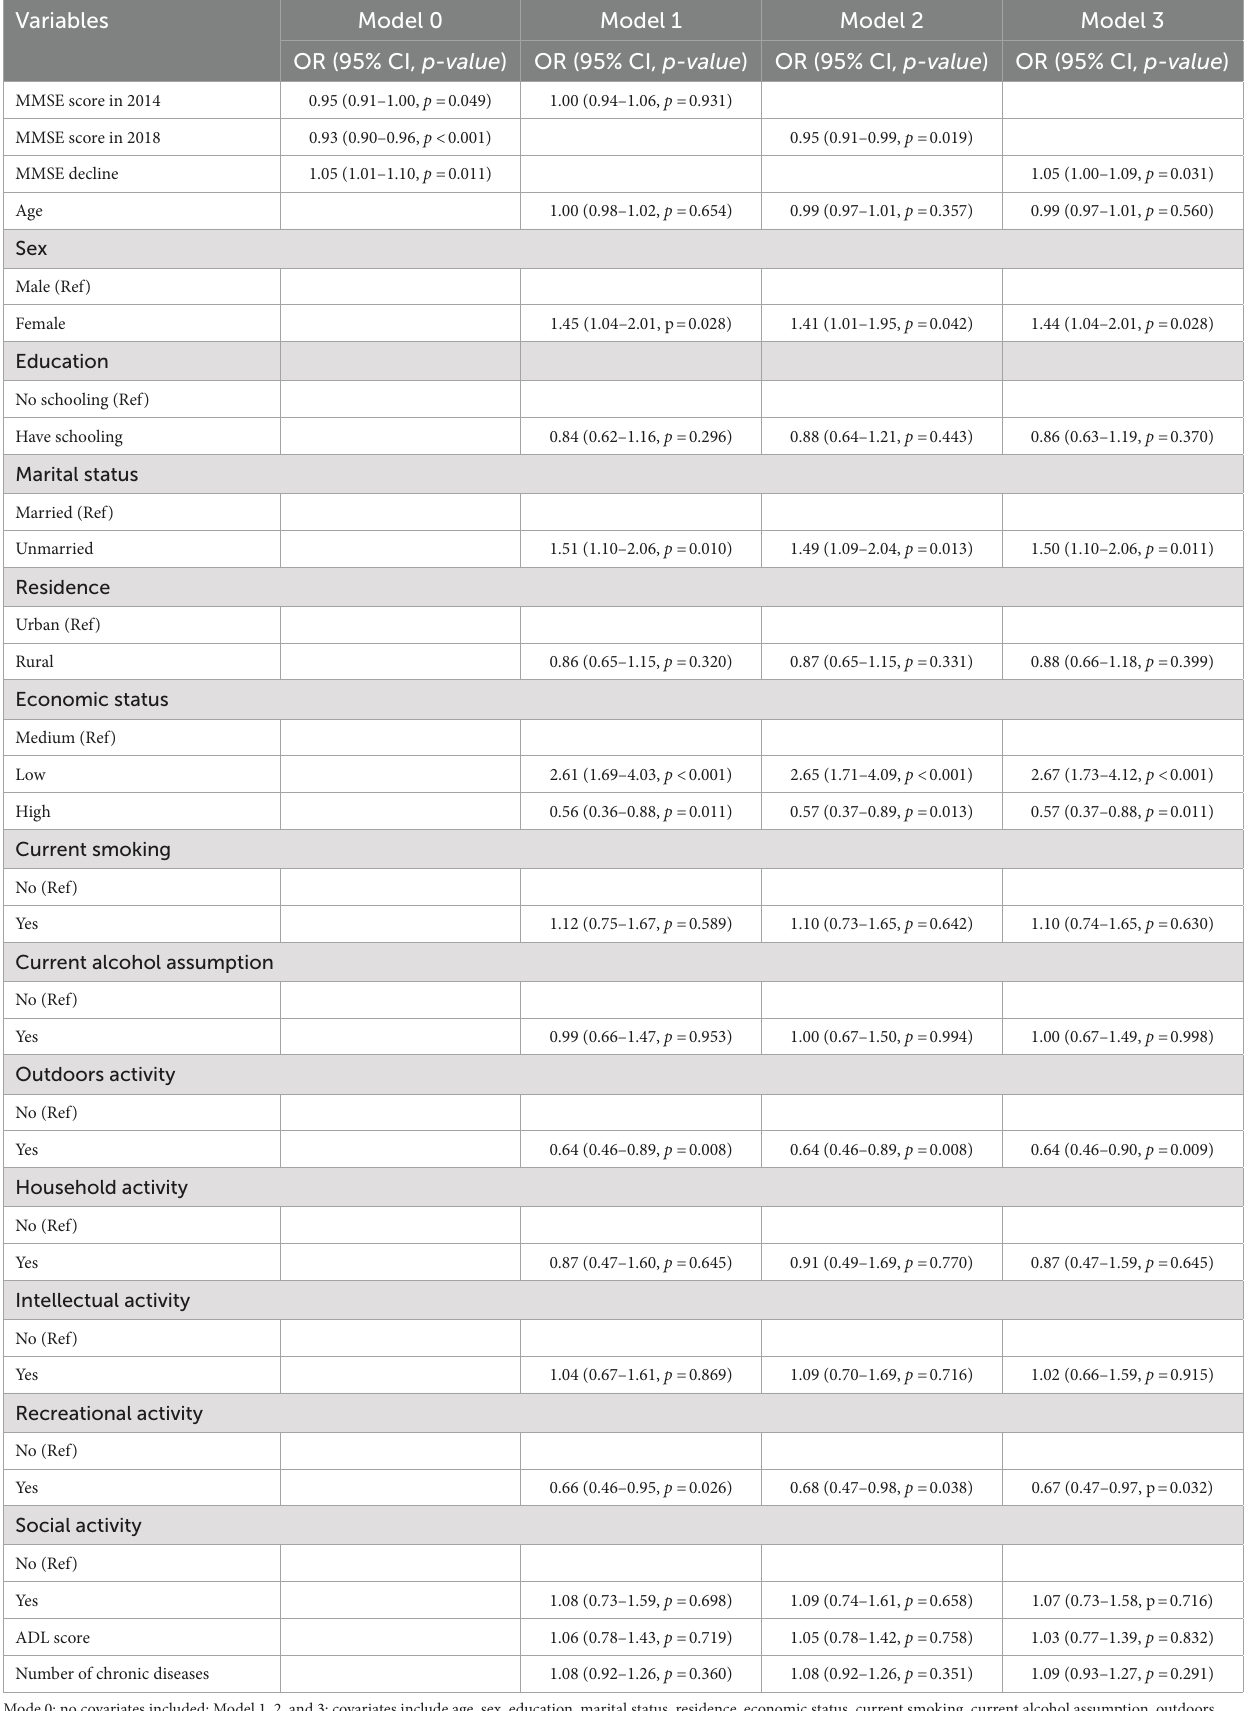
TABLE 2 Logistic regression for the associations between cognitive function, cognitive change, and depressive